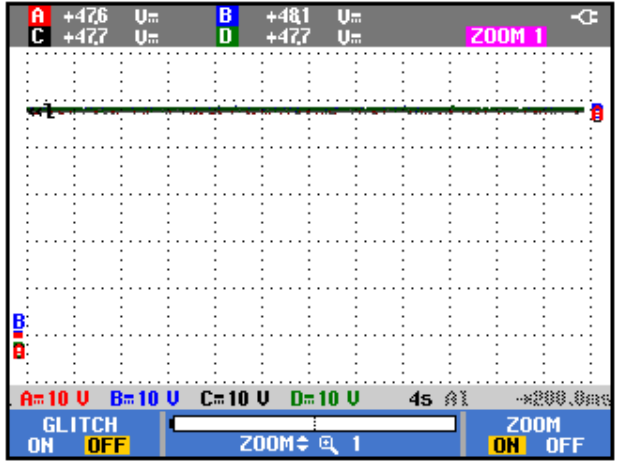
Figure 22. Voltages during sequential current attacks.